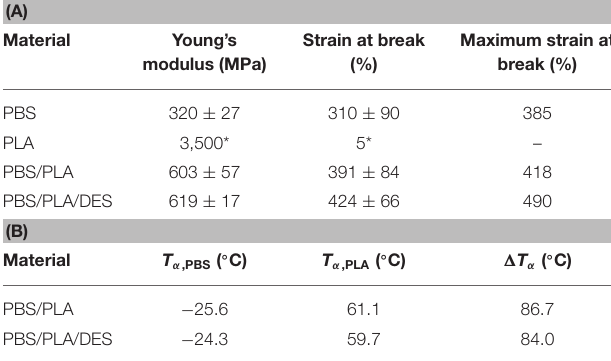
TABLE 2 | (A) Mechanical properties of neat poly(butylene succinate) (PBS) and poly(lactic acid) (PLA) and PBS/PLA blends (uniaxial tension; 50mm min − 1 ) and (B) dynamic mechanical analysis of PBS/PLA blends without and with deep eutectic solvent (DES) (1 wt phr) at 1Hz, 3